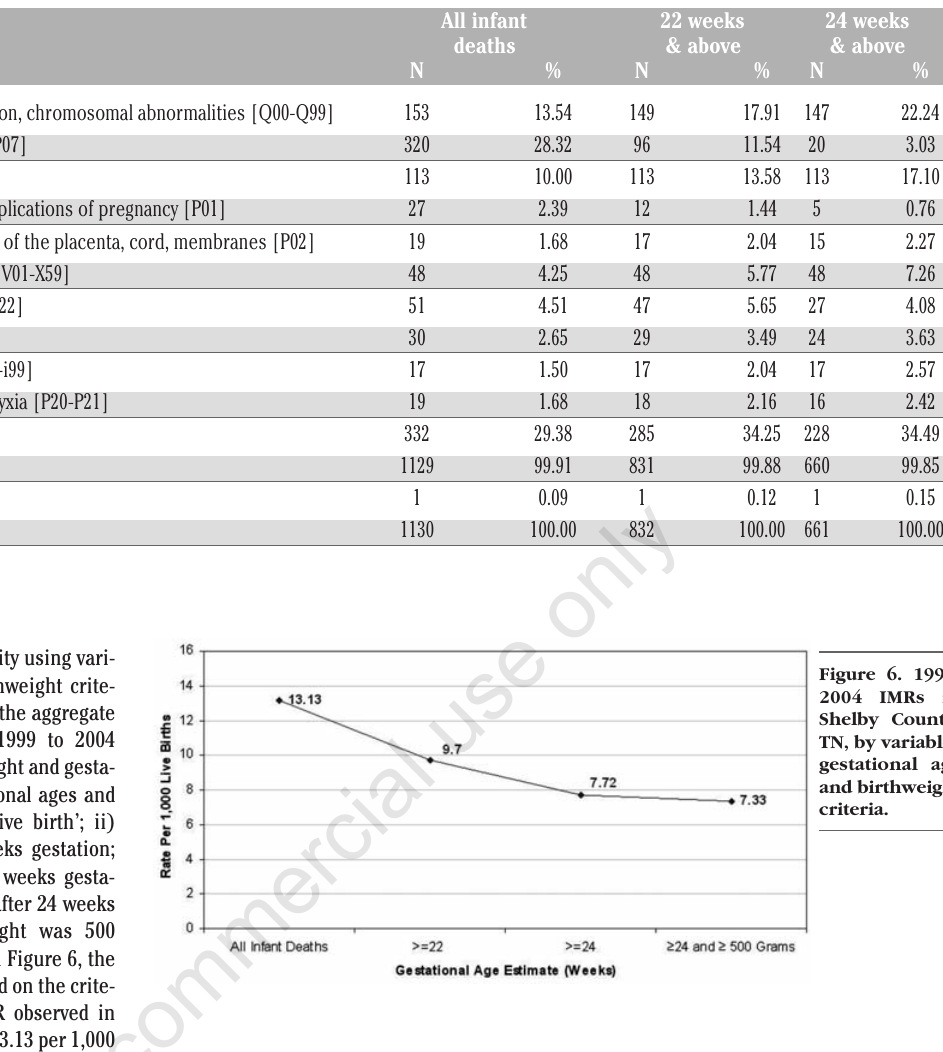
Table 1. Proportional mortality ratio of underlying cause of death per gestational age in Shelby County, TN, 1999-2004. Underlying cause All